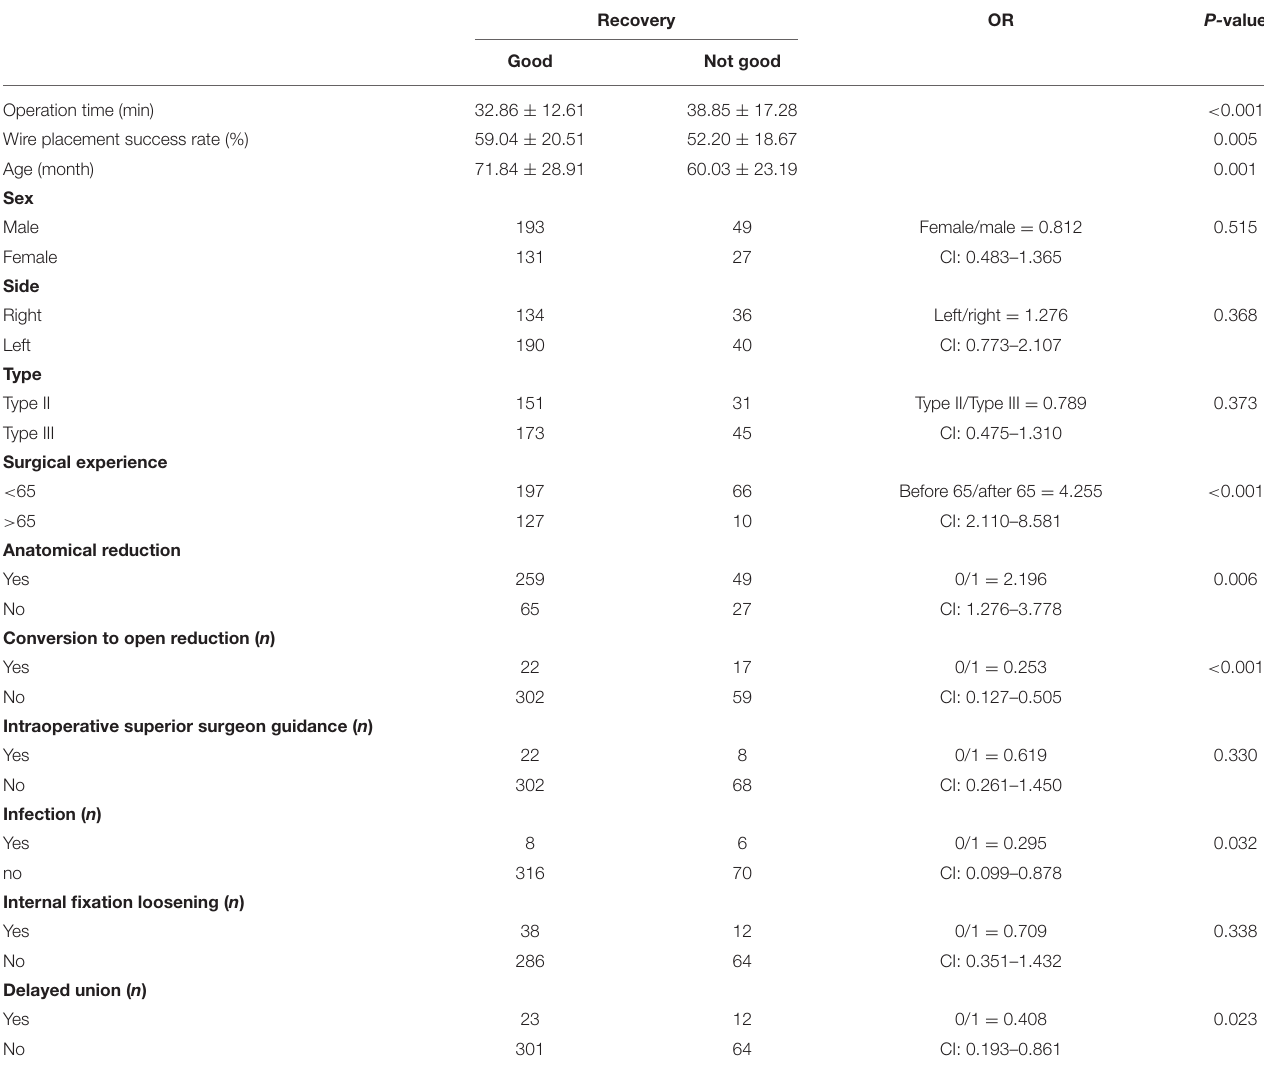
TABLE 5 | Univariate analysis of functional recovery in eligible patient. Recovery OR P-